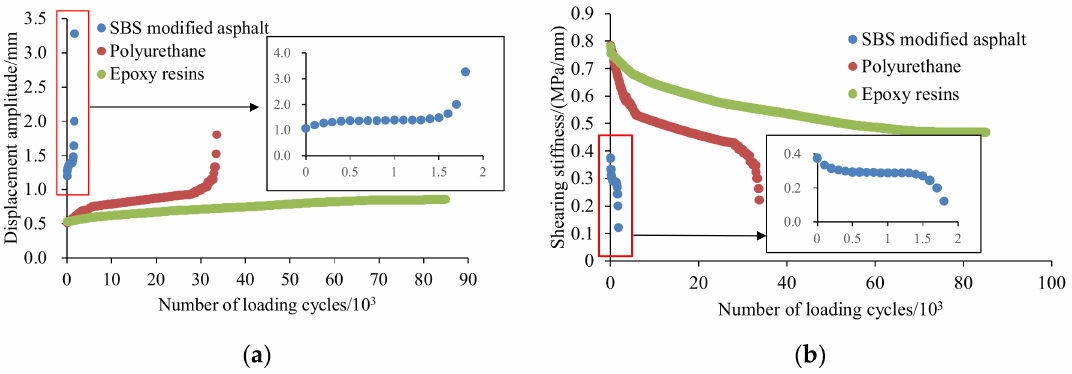
Figure 13. Response curves of ( a ) interface displacement vs. number of loading cycles; and ( b ) shear stiffness vs. number of loading